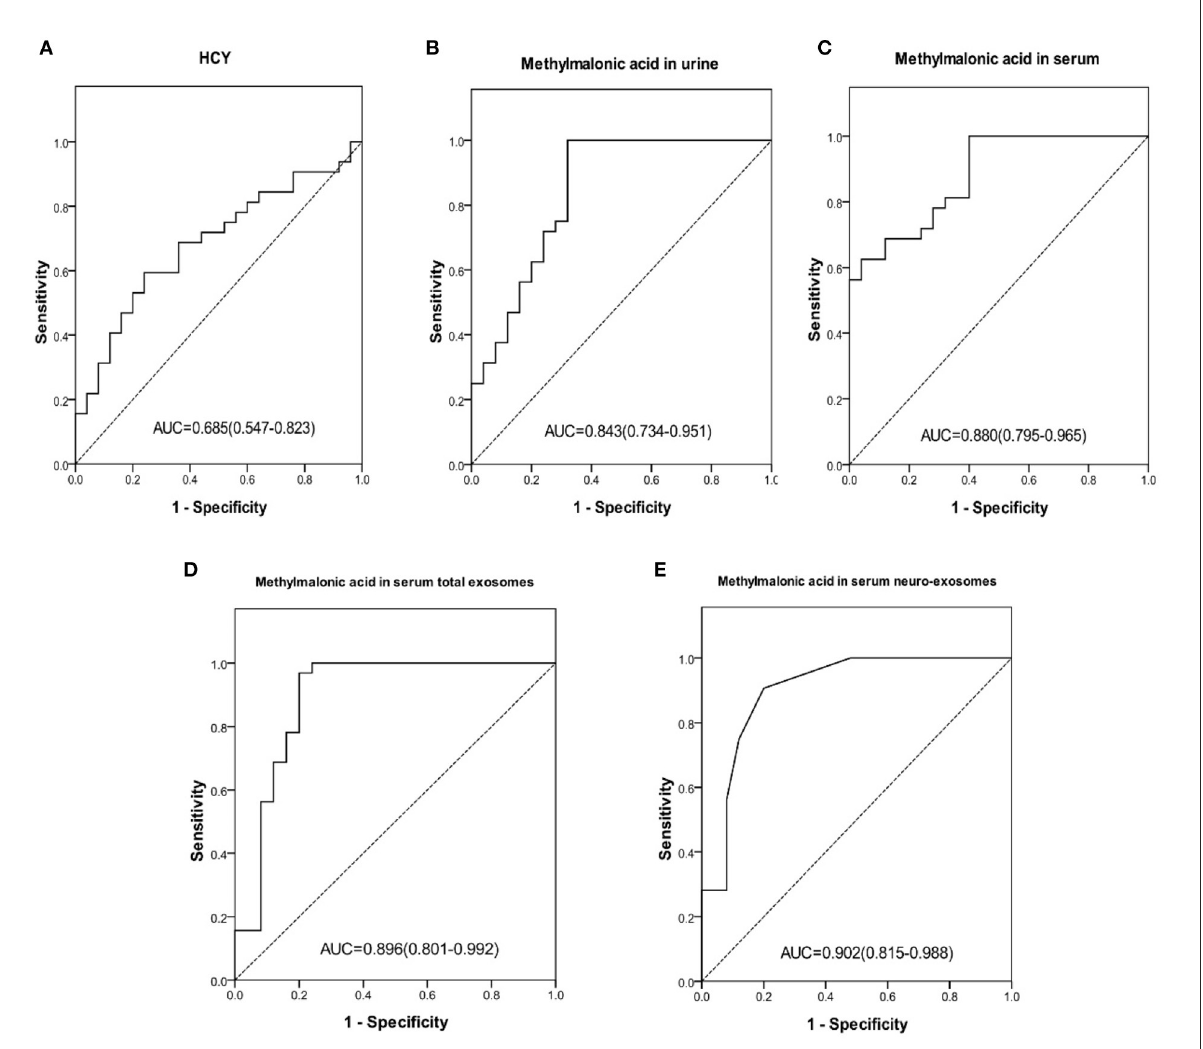
FIGURE2 ROC curve of HCY in serum (A) , methylmalonic acid in urine (B) , methylmalonic acid in serum (C) , methylmalonic acid in serum total exosomes (D) , methylmalonic acid in serum neuro-exosomes (E) individually for distinguishing HHcy patients and cblC-MMA patients with cognitive impairment. ROC, receiver operating characteristic; HCY, homocysteine; neuro-exosomes, neuronal-derived exosomes; HHcy, non-inherited